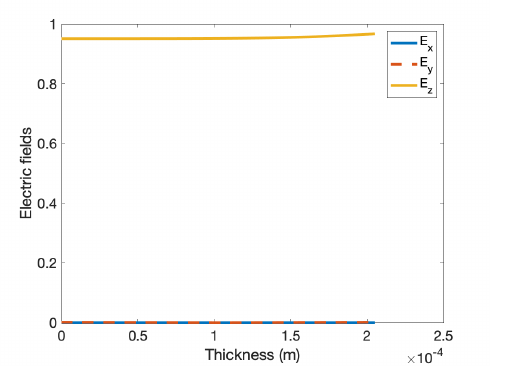
Figure 7. Simulated electric field when the incident field is polarized in the direction of the fibers for ω 2 = 24.5 GHz.